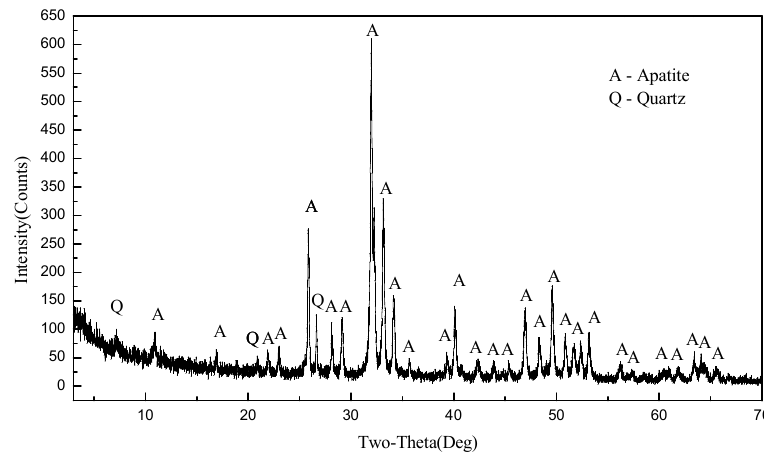
Figure 1. X-ray diffraction (XRD) pattern of the apatite sample.